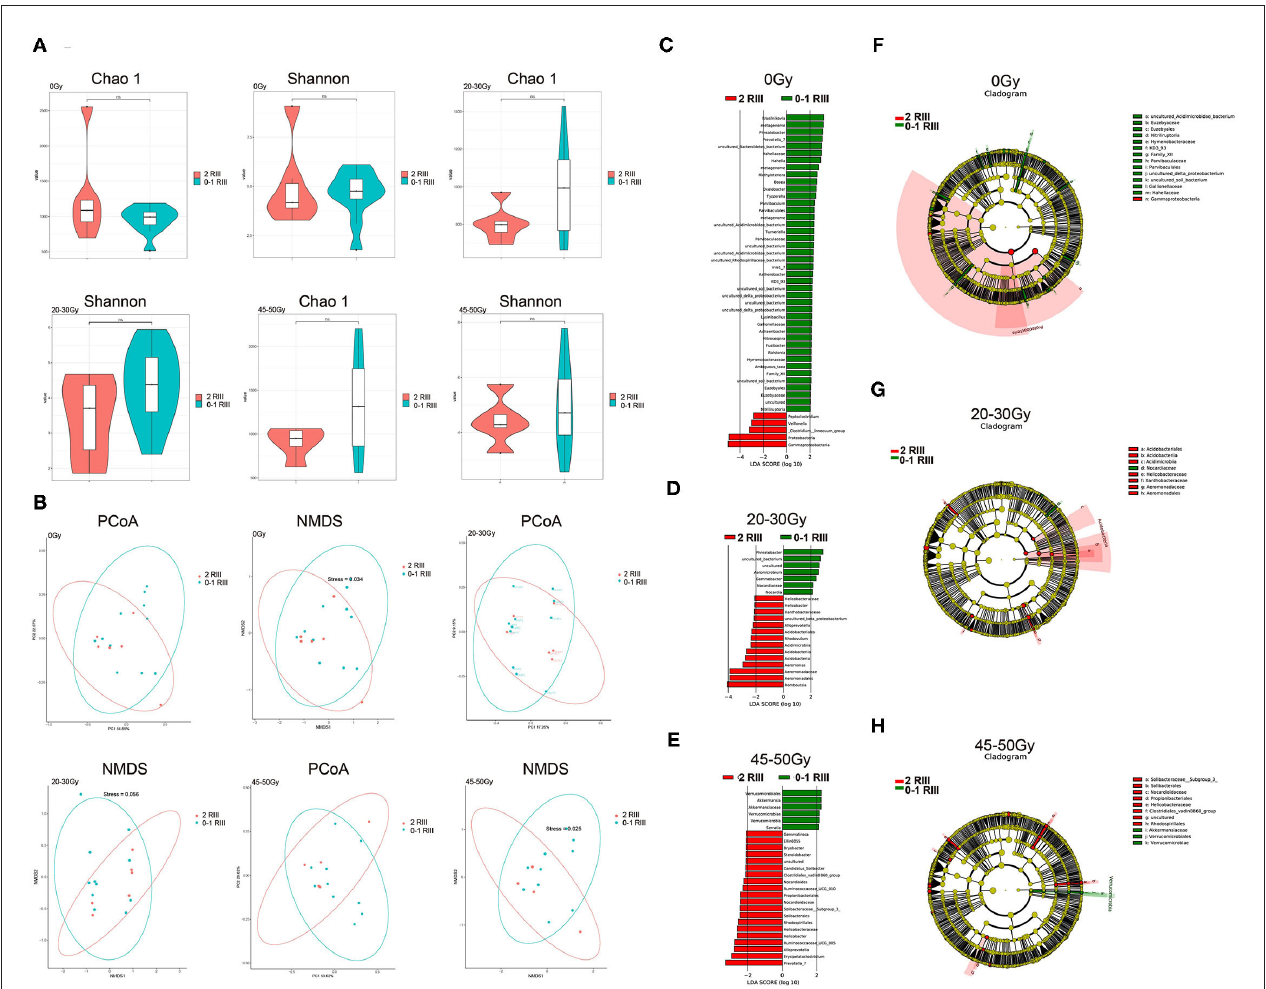
FIGURE 1 | Alterations of gut microbiome between grade 2 and grade 0 or 1 RIII patients at all the three timepoints. (A) Box plot of the Chao1 index and Shannon index. (B) PCoA and NMDS analysis. (C–E) LEfSe analysis based on OTU abundance. (F–H) Taxonomic cladograms with LDA score ≥